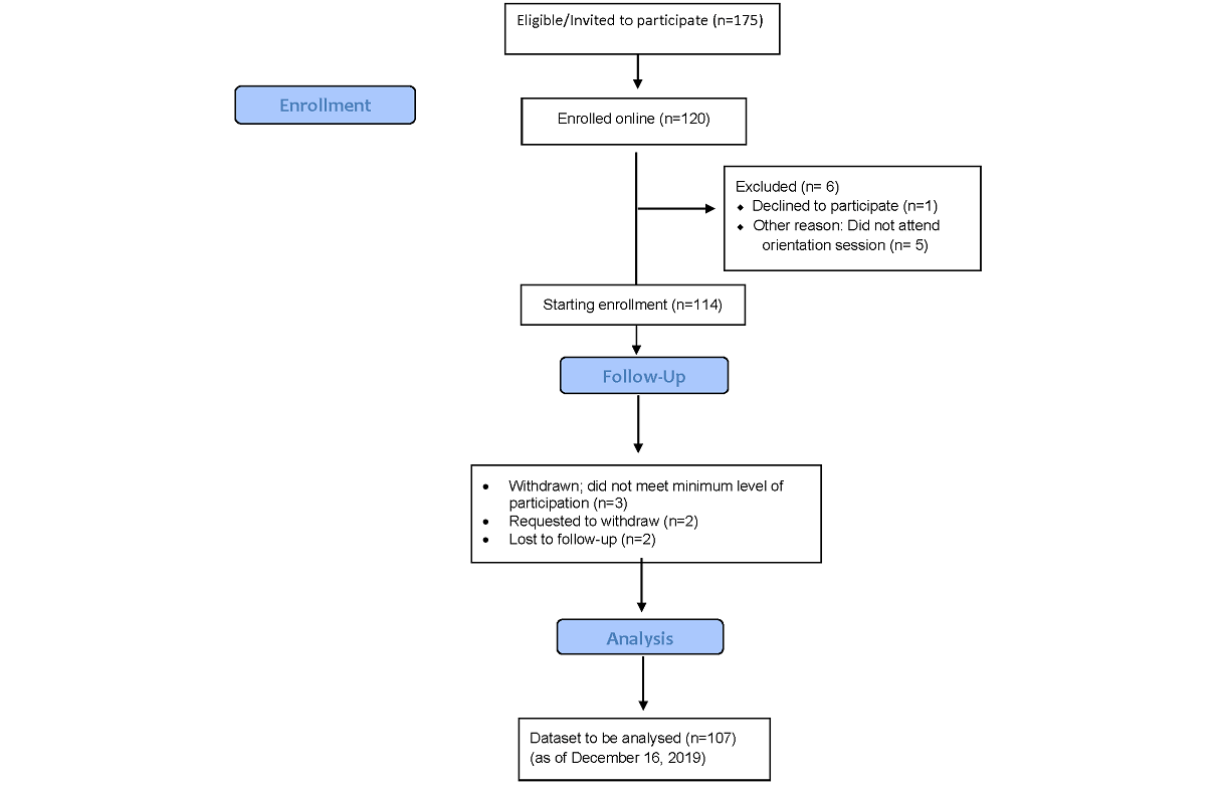
Figure 2. CONSORT Flowchart of WearDuke initiative through end of fall semester.